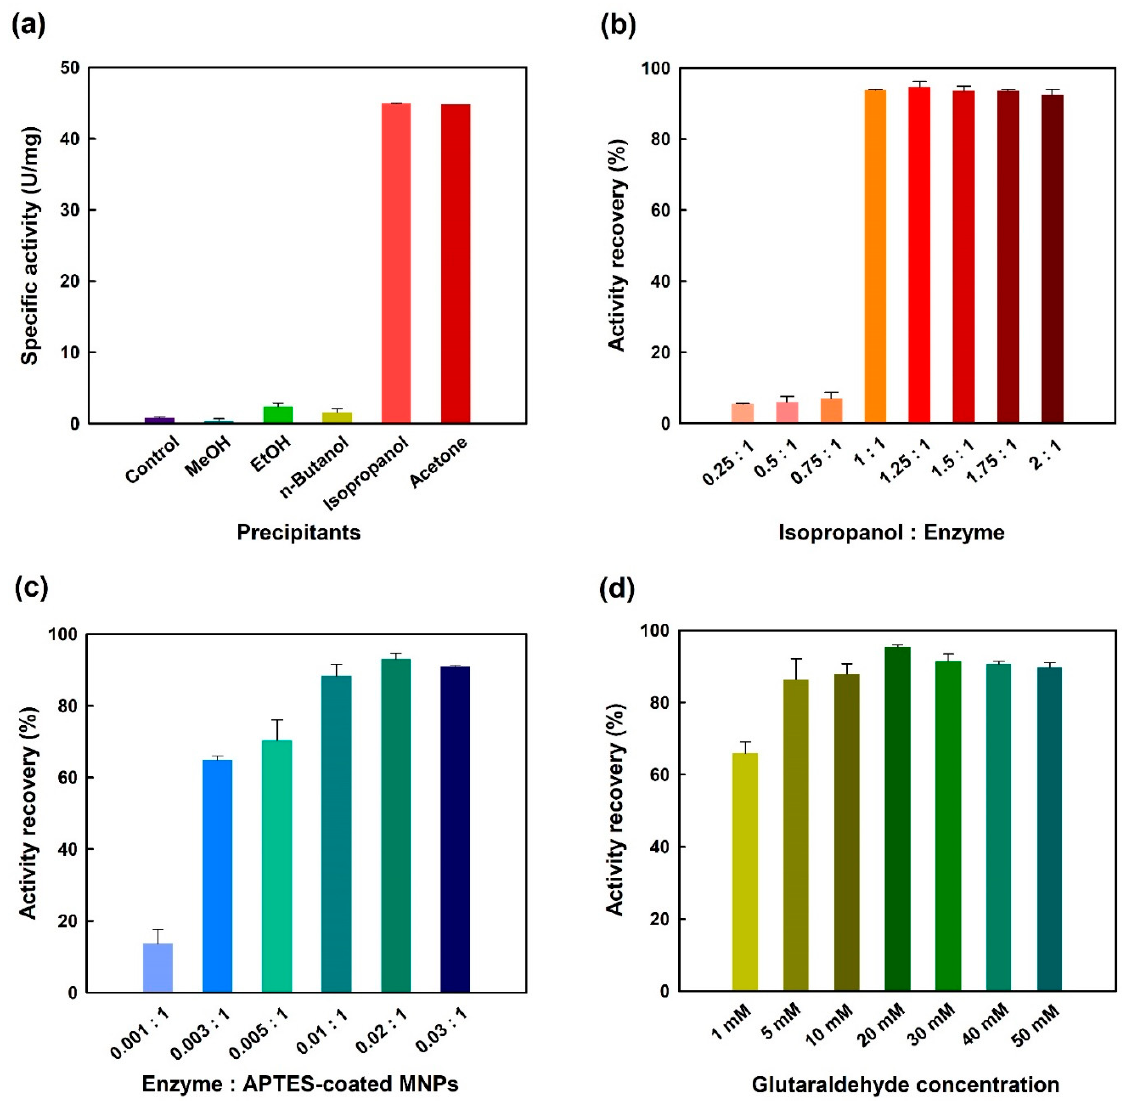
Figure 1. Effects of different precipitants ( a ), isopropanol/enzyme ratio ( b ), enzyme/APTES-coated MNPs ratio ( c ) and glutaraldehyde concentration ( d ) on the immobilization of N450D. Control group in panel ( a ) represents enzyme sample without the addition of precipitating agent.